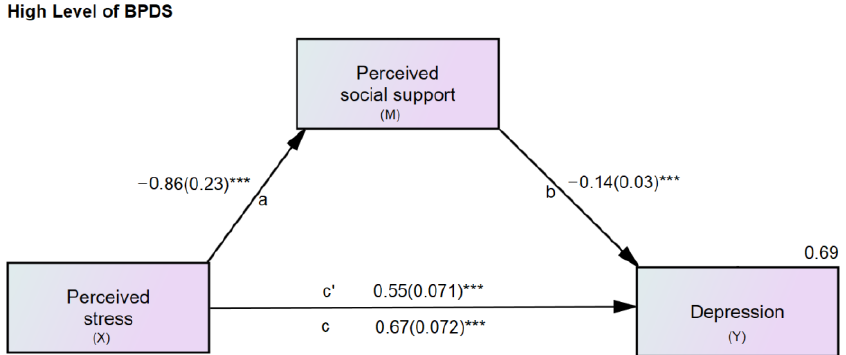
Table 2. Comparison of the correlation coefficients between low levels of BPDS and high levels of BPDS. Figure 2. Clustered bar graphs illustrating dots, means, and confidence intervals for each group using a bar chart with error bars. BPDS = borderline personality disorder symptoms.